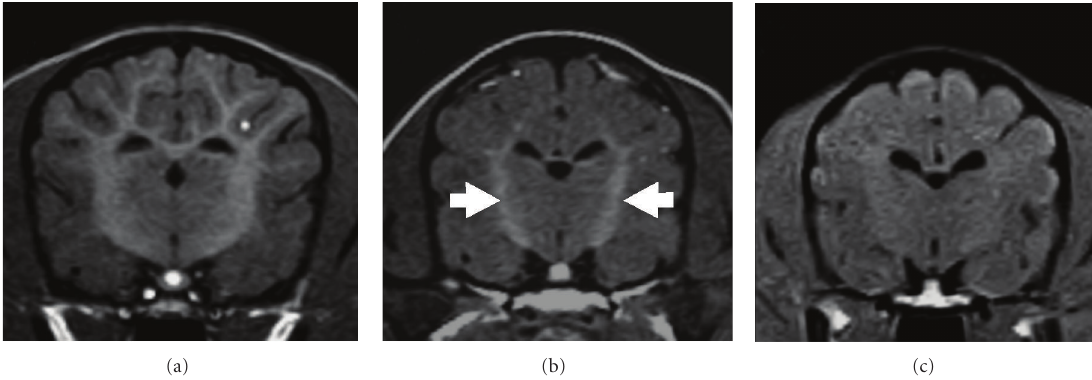
Figure 4: Transverse T1W images at the level of the thalamus/3rd ventricle. (a) An age-matched control dog at 2 months of age, (b) an a ff ected laboratory dog at 2 months of age, (c) clinical case (animal 1) at 3 months of age. Symmetrical T1W hyperintensity was found in the internal capsule (arrows) in the a ff ected laboratory dog (b), whereas there was no apparent hyperintensity in animal 1 (c). However, this internal capsule T1W intensity in the a ff ected dog was not higher than that observed in the control dog